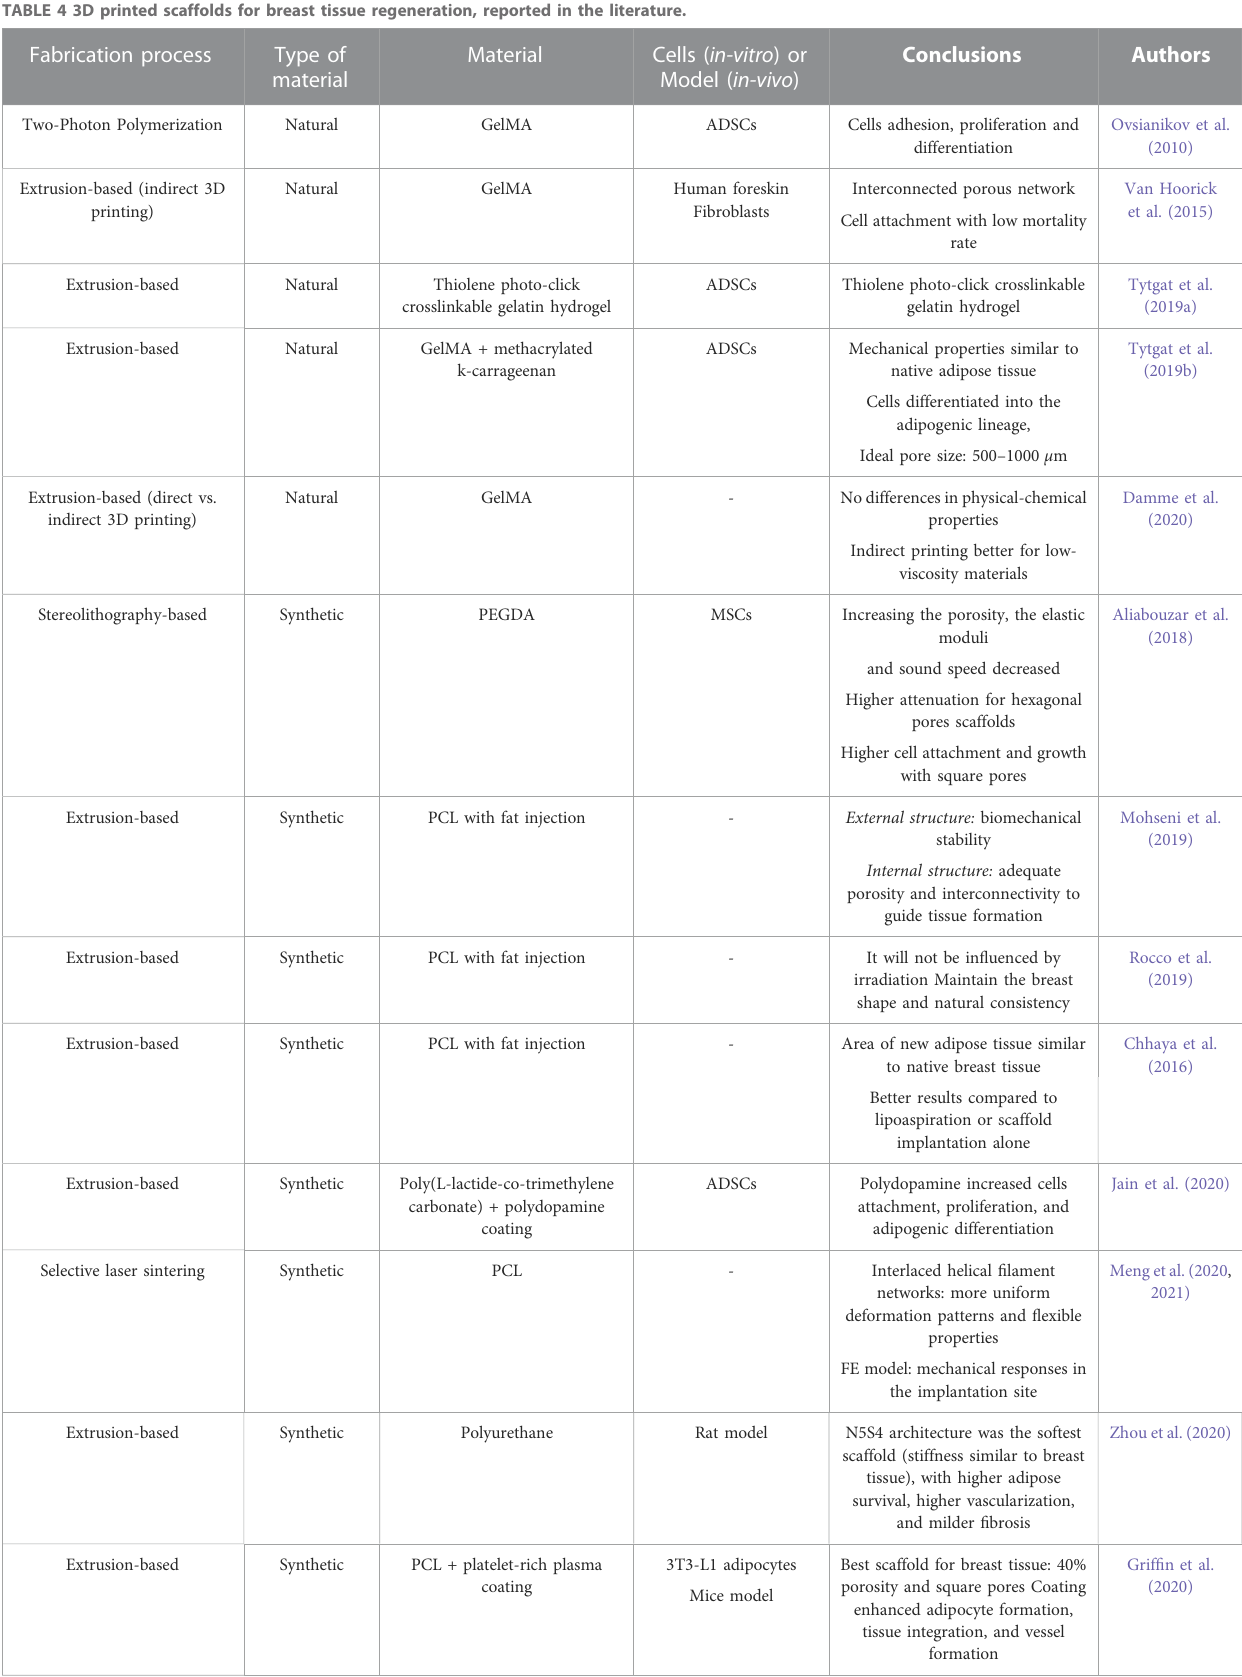
TABLE 4 3D printed scaffolds for breast tissue regeneration, reported in the